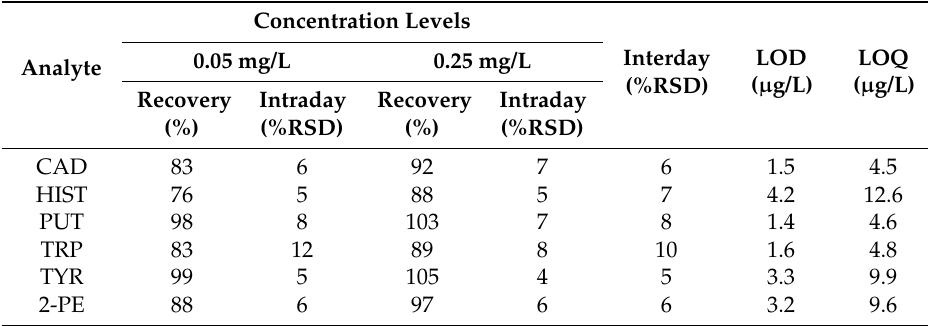
Table 5. Information on average recoveries (%), intra-day repeatability (%RSD), inter-day repeatability (%RSD), and limits of detection (LOD, ( µ g/L) and limits of quantification (LOQ, ( µ g/L)) obtained